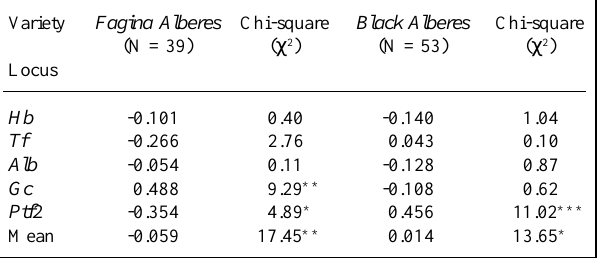
Table IV - Estimated F values for each locus and variety of “Alberes” IS cattle breed a , and mean estimates for both varieties. Variety Fagina Alberes